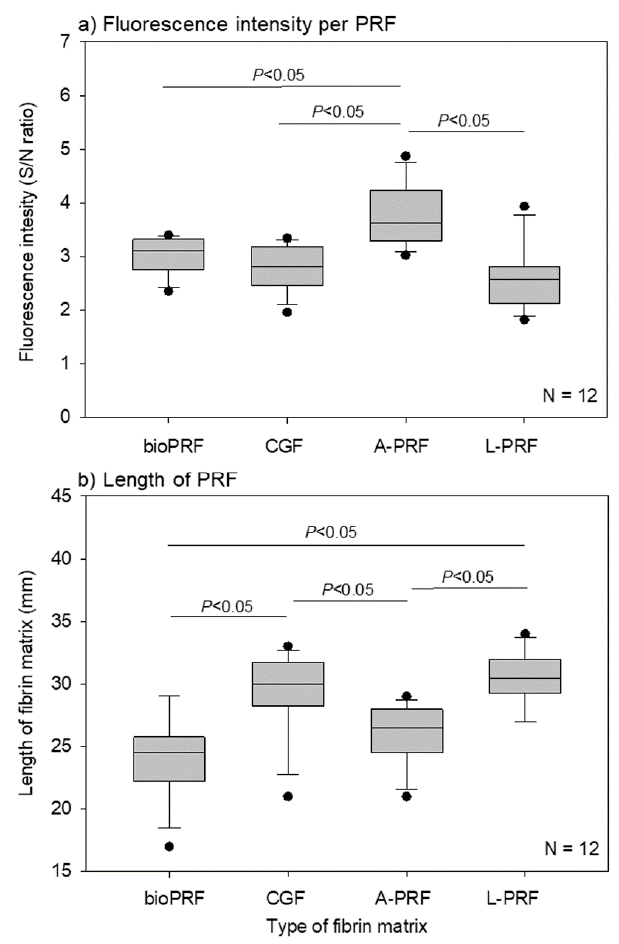
Figure 2. ( a ) Specific fluorescence intensities of individual half platelet-rich fibrin (PRF) matrices. The data are expressed as the CD41 + -isotype control ratio. n = 12. ( b ) The lengths of individual PRF matrices. n = 12.